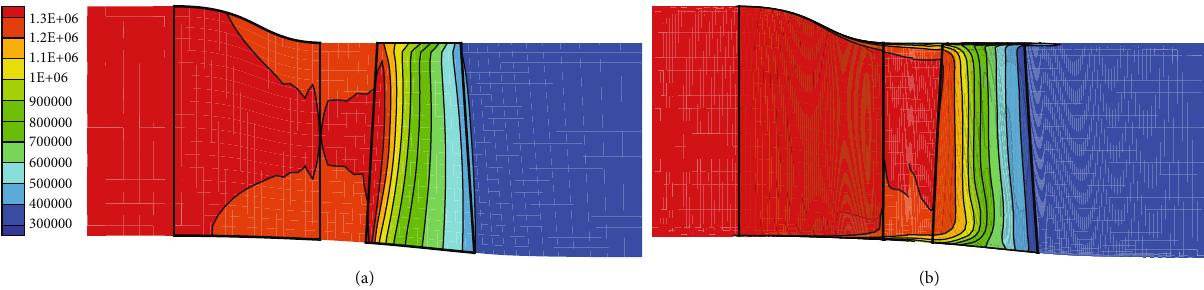
Figure 18: Total pressure of the single-stage turbine: (a) Q3D; (b) 3D.